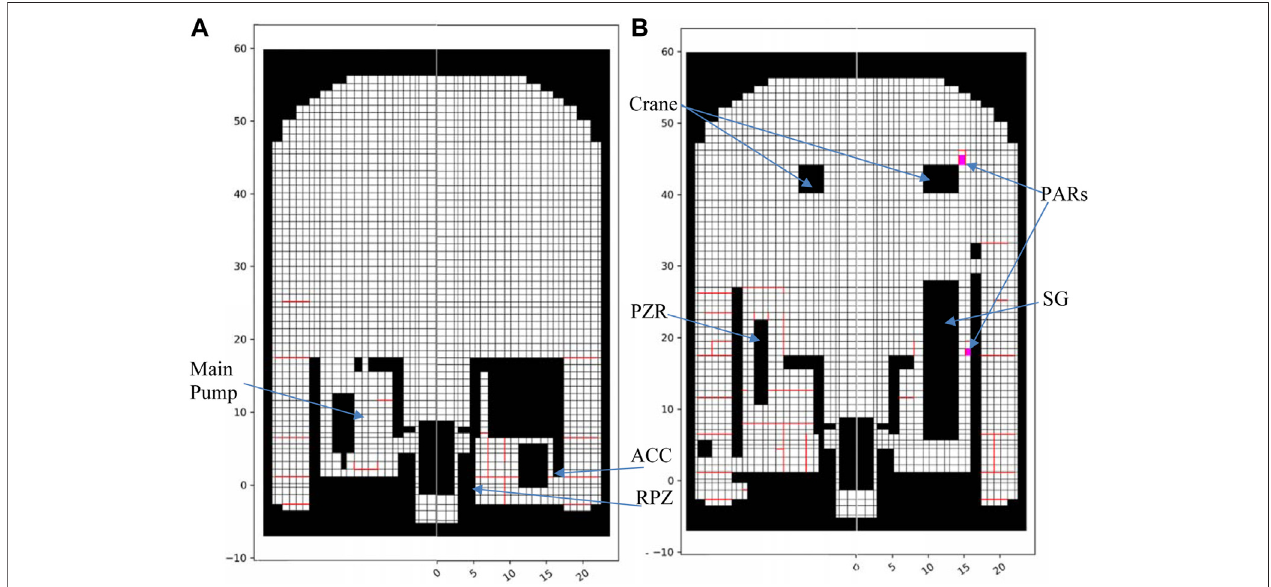
FIGURE 5 | R-Z view of the containment geometry model-case0. (A) 0 ° and 180 ° . (B) SG and PZR compartment.